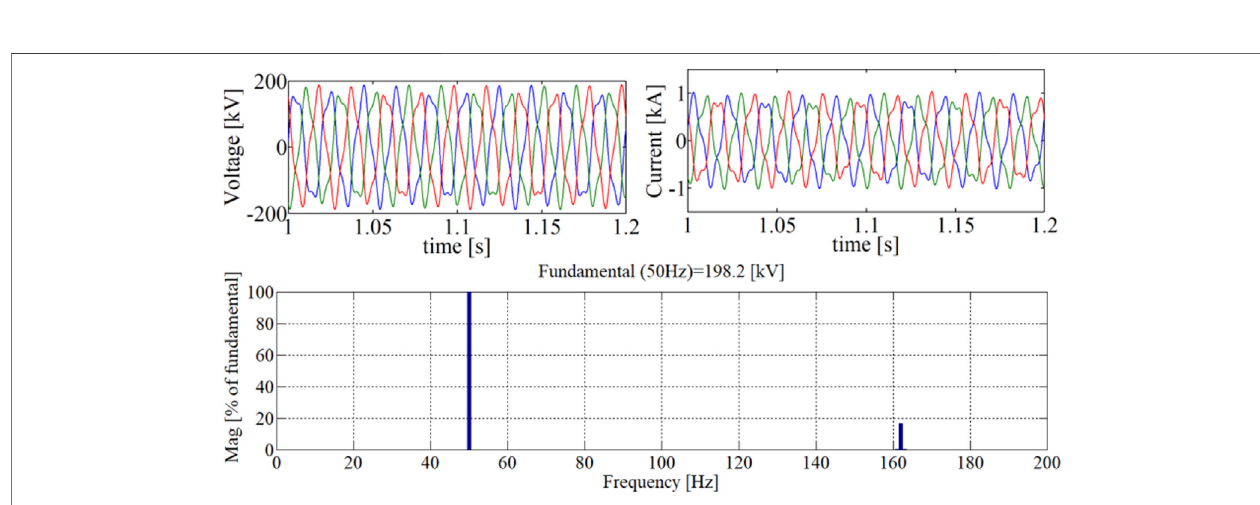
FIGURE 15 | Three-phase voltage and current at the local grid side and the FFT of voltage with 50% capacitive reactive power output of VSC. SCR (cid:2) 2.5.